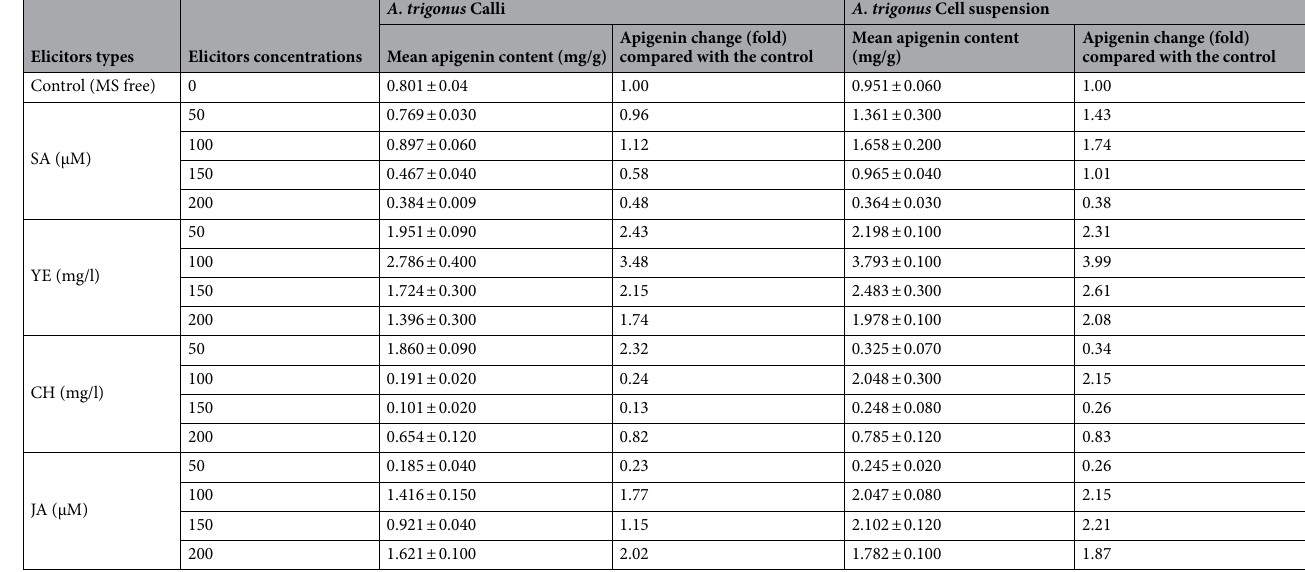
Table 1. Effect of elicitor treatments on apigenin contents. HPLC was used for measuring the apigenin concentration in the six weeks A. trigonus calli and cell suspension cultures incubated on MS media supplemented with different concentrations of SA, YE, JA and